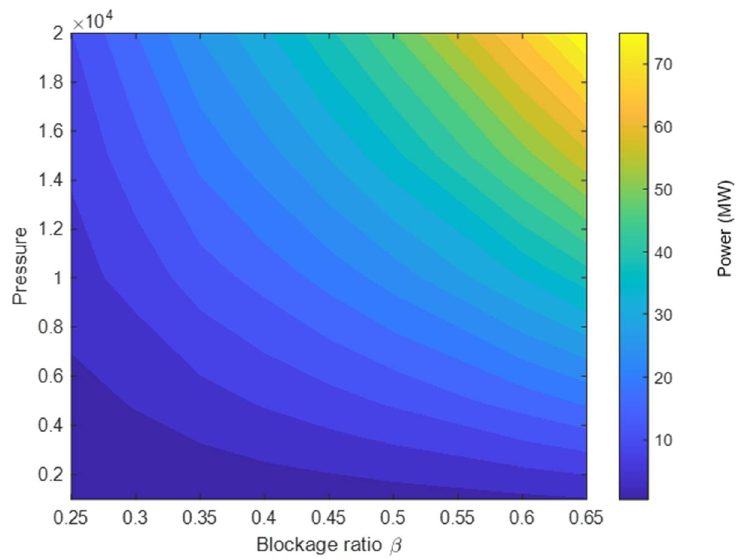
Figure 6. Effect of blockage ratio on vehicle’s power at various operating pressures, M = 0.6.